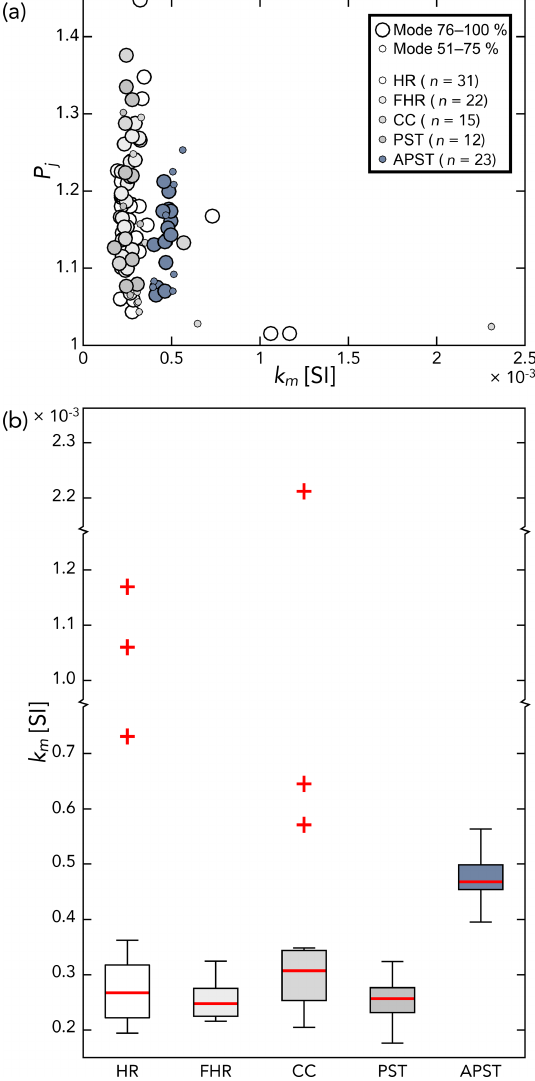
Figure 7. Variation of anisotropy degree ( P j ) and shape ( T ) param- eters for AMS of different rock types. None of the rock types are distinct from the others based on these parameters (a) . (b–c) Box- and-whisker plots for P j and T . HR – host rock, FHR – fractured host rock, CC – cataclasite, PST – pseudotachylyte, APST – altered pseudotachylyte.